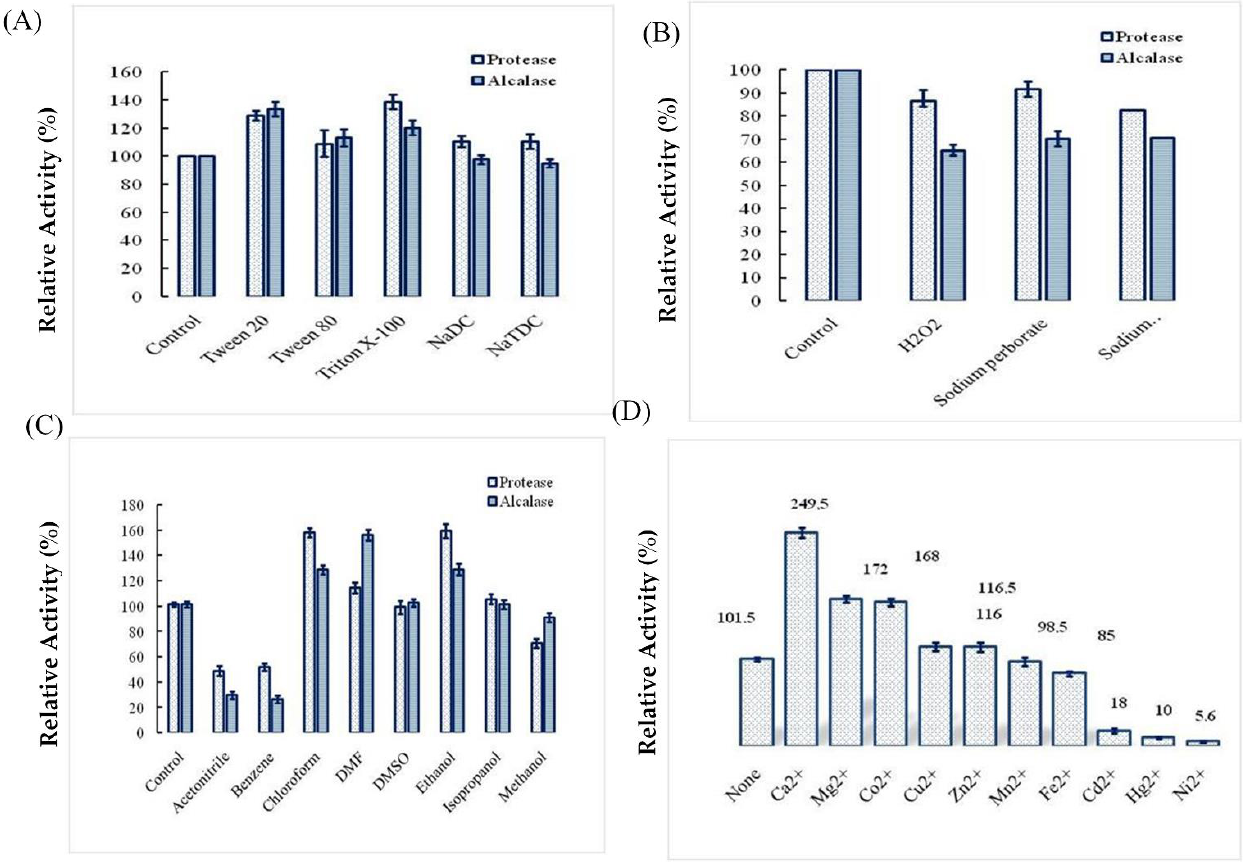
Figure 7. Effects of surfactants ( A ), oxidizing agents ( B ), organic solvents ( C ), and divalent ions ( D ) on Ba.St.Pr stability. The enzyme was incubated with the appropriate agent for 1 h, and the residual activity was measured at the optimal conditions. A commercial Alcalase 2.5 L, type DX, was used as a positive control.